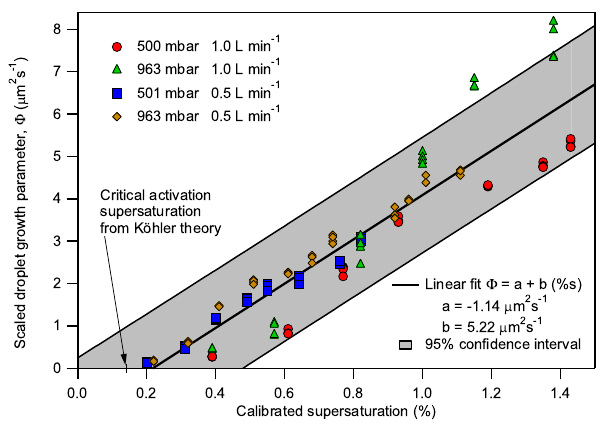
Fig. A1. Dimensionless scaling of droplet size ( 8 ) versus calibrated instrument supersaturation for measured 100nm ammonium sulfate particles.